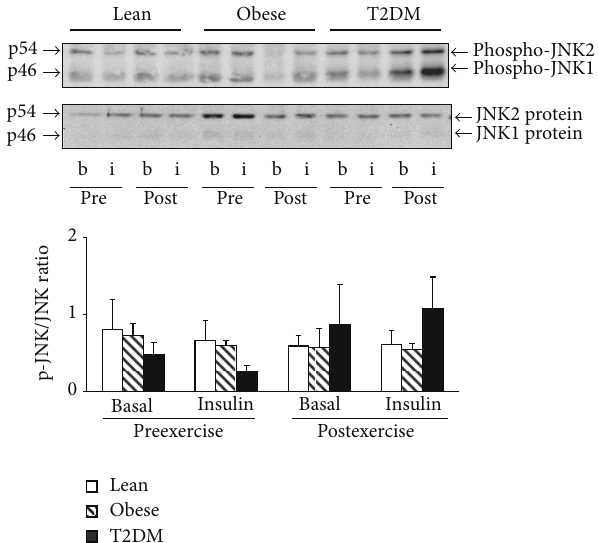
Figure 4: JNK phosphorylation and protein content. Phosphoryla- tion of JNK and JNK protein was measured in PMNC from 17 lean, 8 obese, and 11 T2DM individuals at the basal state (b) and at the end oftheinsulinclamp(i)before(pre)andafter(post)exercisetraining. Data are means ± SE. Blots are shown for one lean, one obese, and one T2DM individual. a.u.: arbitrary units.